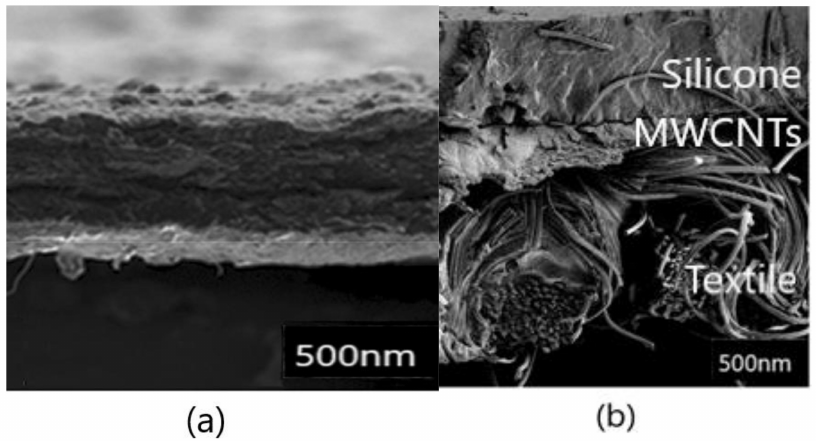
Figure 3. ( a ) The cross-section of a MWCNT film (above) and supporting TPU filtering membrane (underneath). ( b ) MWCNT composite cross-section after the melt welding.